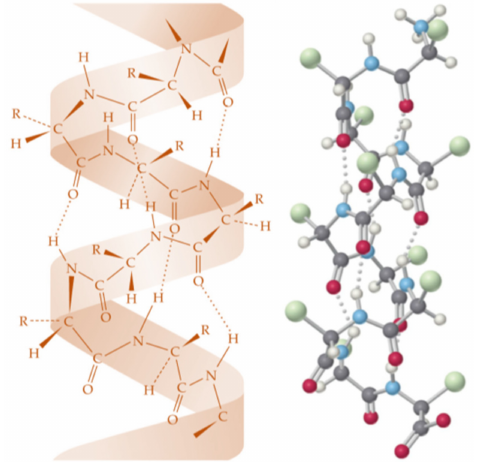
Figure 3. Partial structure of collagen alpha helix with its hydrogen